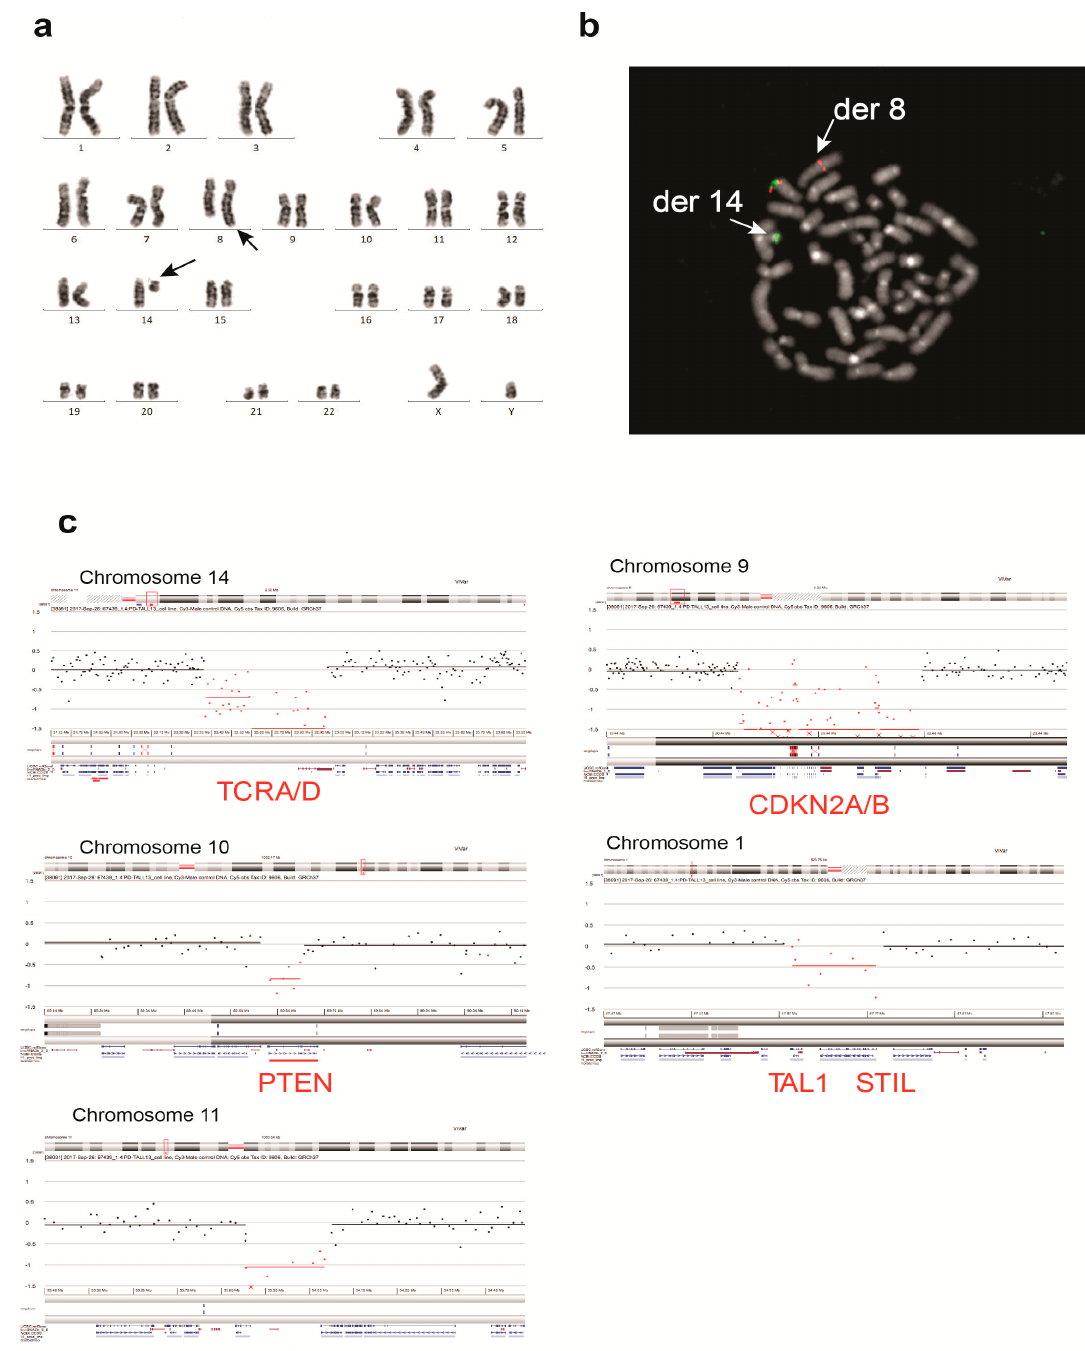
Figure 2. Cytogenetic and molecular characterization of the UP-ALL13 cell line. ( a ) Cytogenetic analysis described a t(8;14)(q24;q11) translocation as a single clonal chromosomal abnormality (arrows). ( b ) Fluorescence in situ hybridization (FISH) analysis performed on metaphases using a break-apart probe for MYC confirmed MYC rearrangement on t(8;14)(q24;q11) translocation by demonstrating the presence of the 5’MYC probe on the derivative chromosome 8 (der 8) and the translocation of the 3’ MYC probe on the derivative chromosome 14 (der 14). ( c ) Array comparative genomic hybridization (CGH) results of UP-ALL13 cells showing deletions involving TCRA/D , CDKN2A/B , PTEN , TAL1/STIL , and LMO2 loci.